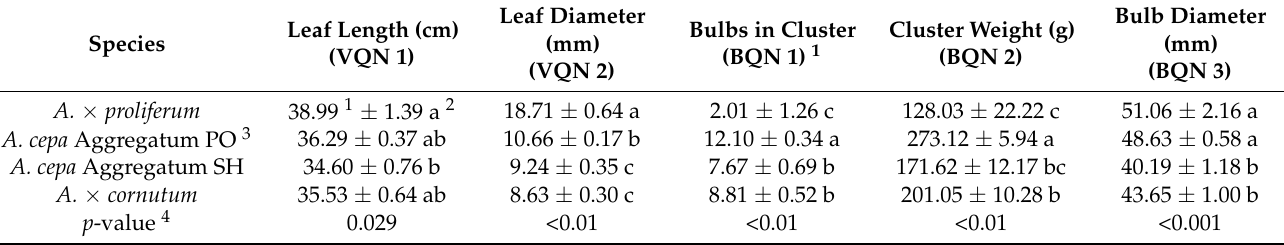
Table 5. Quantitative vegetative and bulb morphology